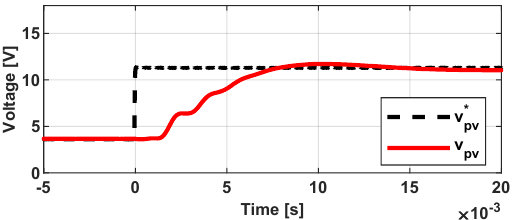
Figure 10. Step response of the voltage v PV using the predictive